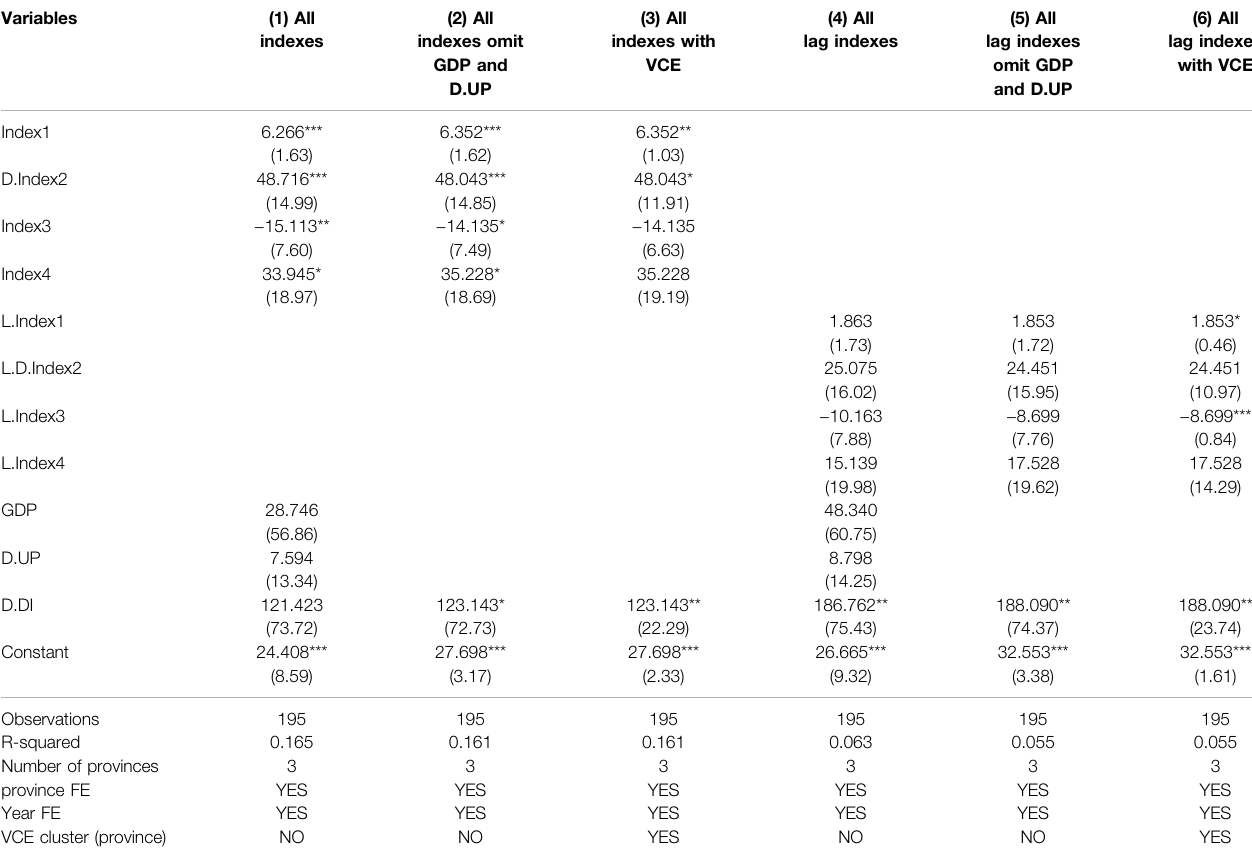
TABLE 9 | Model estimation results using Baidu search index regarding the northeast area of China.